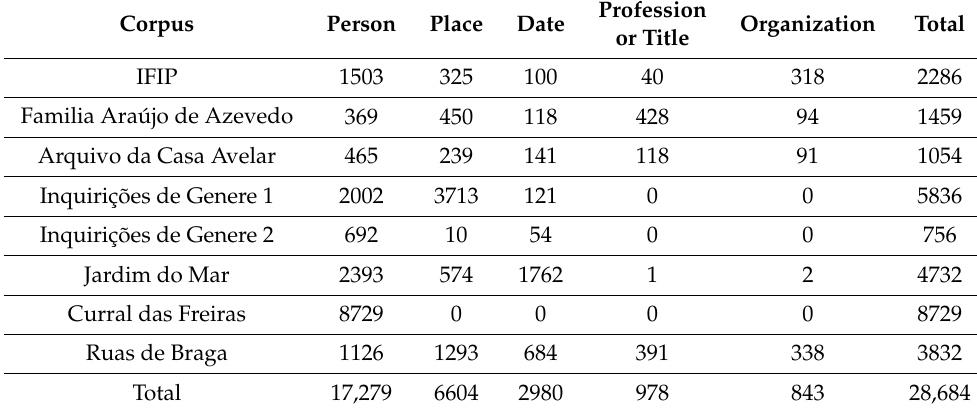
Table 1. Number of annotated entities per